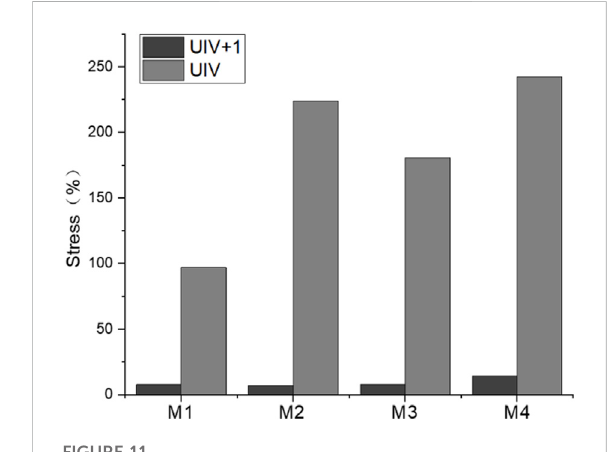
FIGURE 9 The maximum stress of M1 – M4 growing rods.